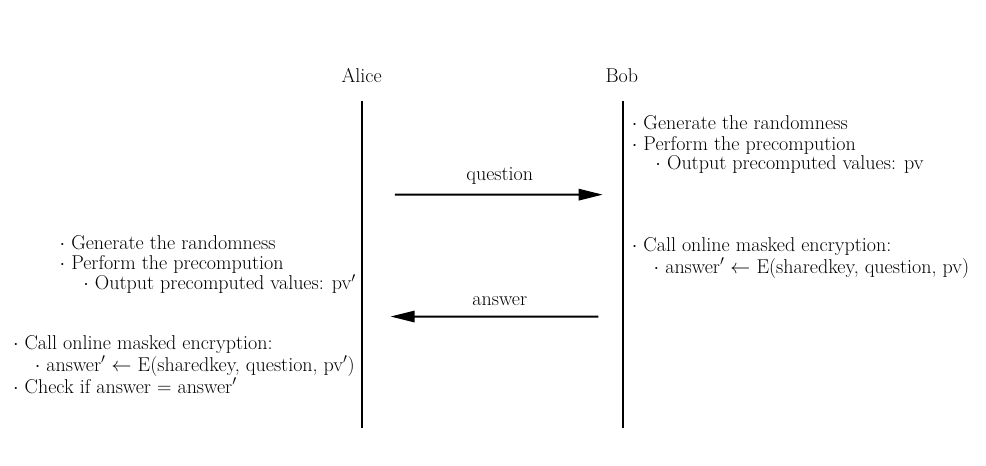
Figure 3: Precomputation-based design paradigm for challenge–response authentication